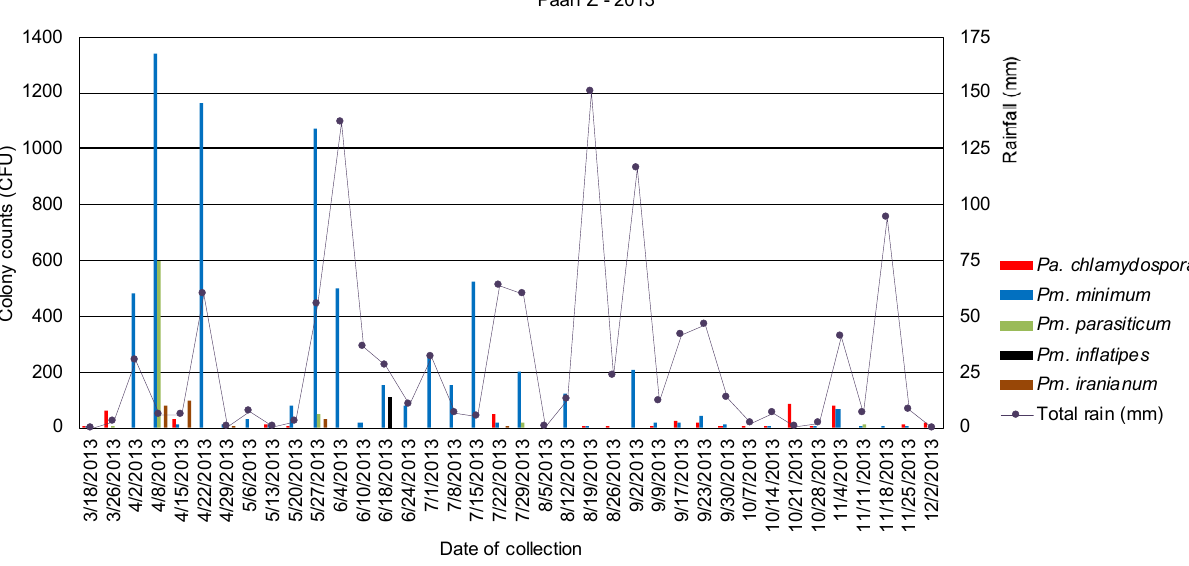
Figure 4. Phaeomoniella and Phaeoacremonium spp. cfu cultured from five vaseline coated microscope slides affixed to the cordons on each of five vines in vineyard Paarl Z, Western Cape province in 2013. The slides were replaced weekly. Each bar represents the total number of cfu cultured on three Petri